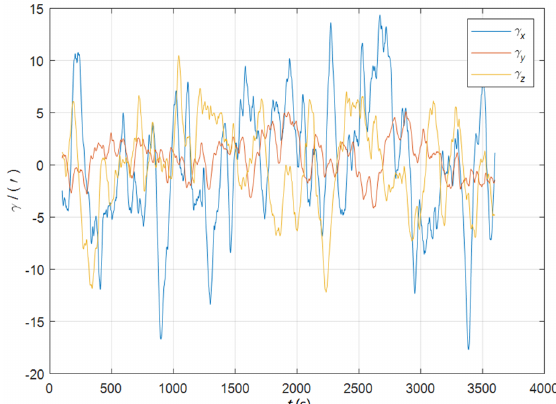
Figure 12. The curves of the dynamic deflection angle in the quasi-static swing base.